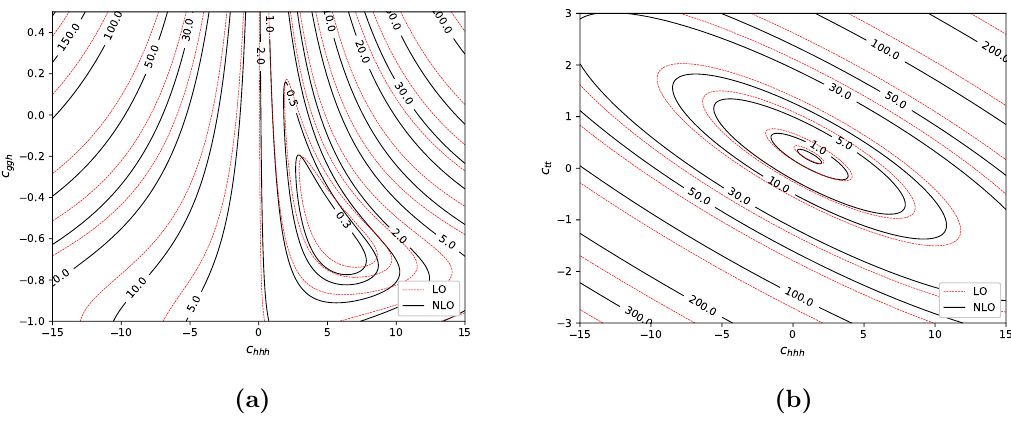
Figure 8. Iso-contours of (cid:27)=(cid:27) SM : (a) c ggh versus c hhh and (b) c tt versus c hhh .